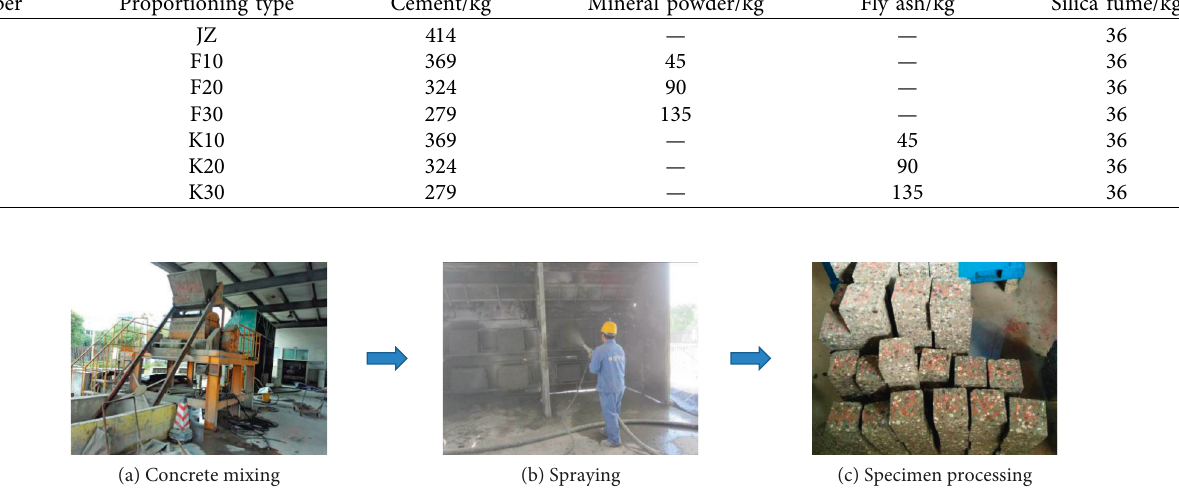
Figure 3: Production of shotcrete specimen. (a) Concrete mixing. (b) Spraying. (c) Specimen